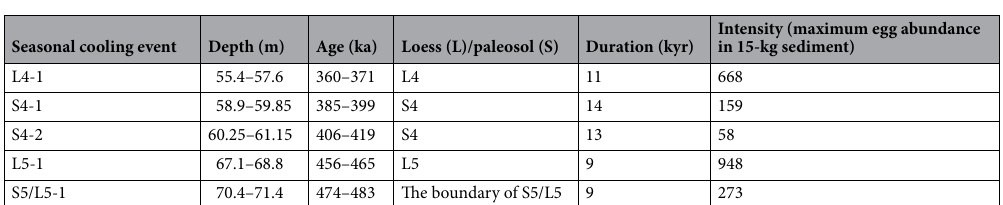
Table 1. Seasonal cooling events and their depth, age, duration and egg abundances in the Huining loess– paleosol sequence during MIS 12–10.